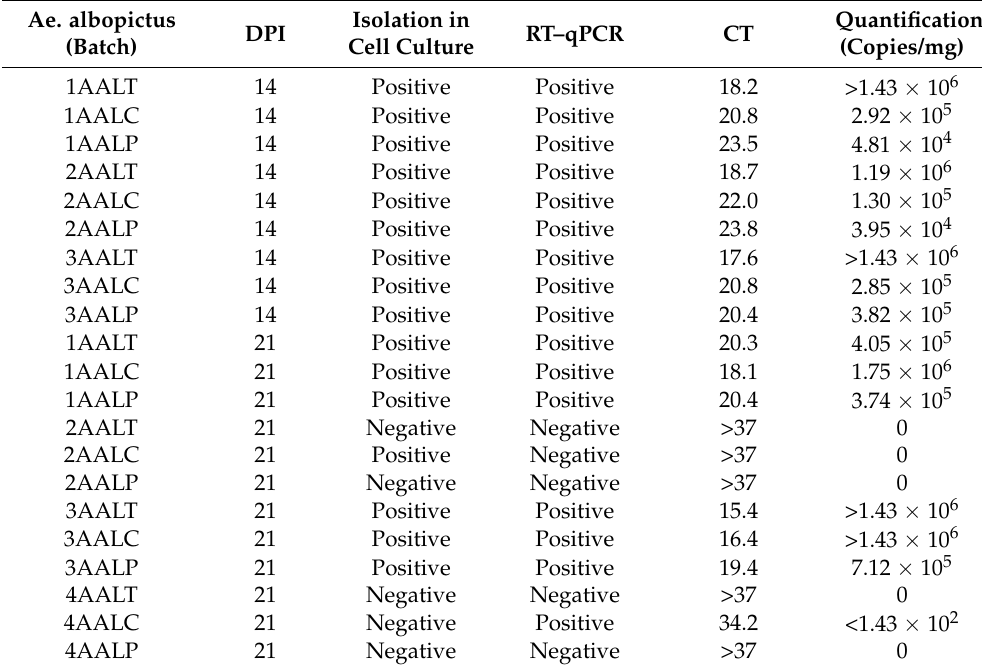
Table 1. Ae. albopictus batches, dpi, cell culture results, and RT‒qPCR quantification of YFV. Ae. albopictus